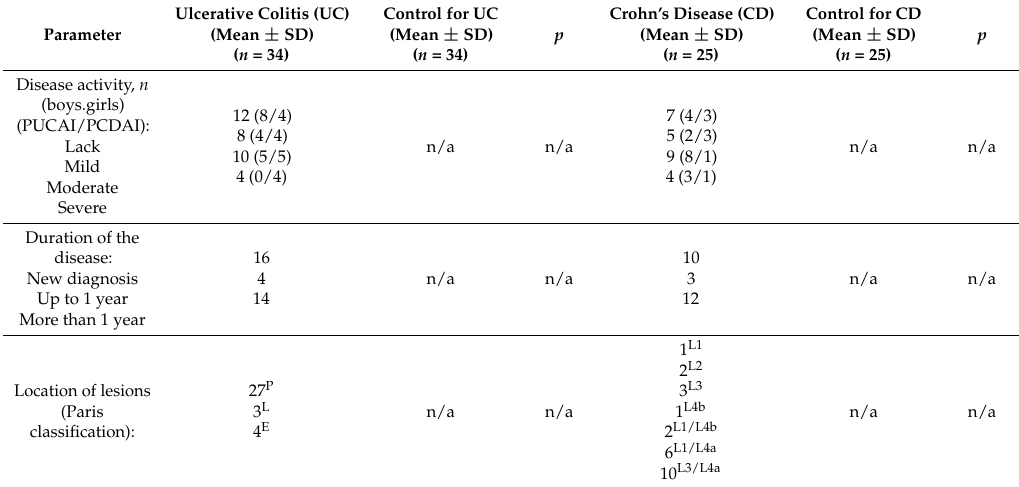
Table 1. Demographic and anthropometric parameters of the study